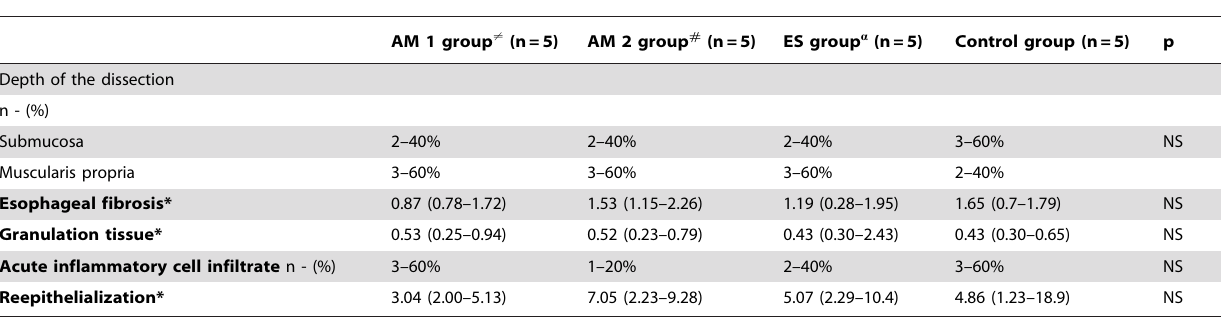
Table 2. Histological evaluation of the esophageal